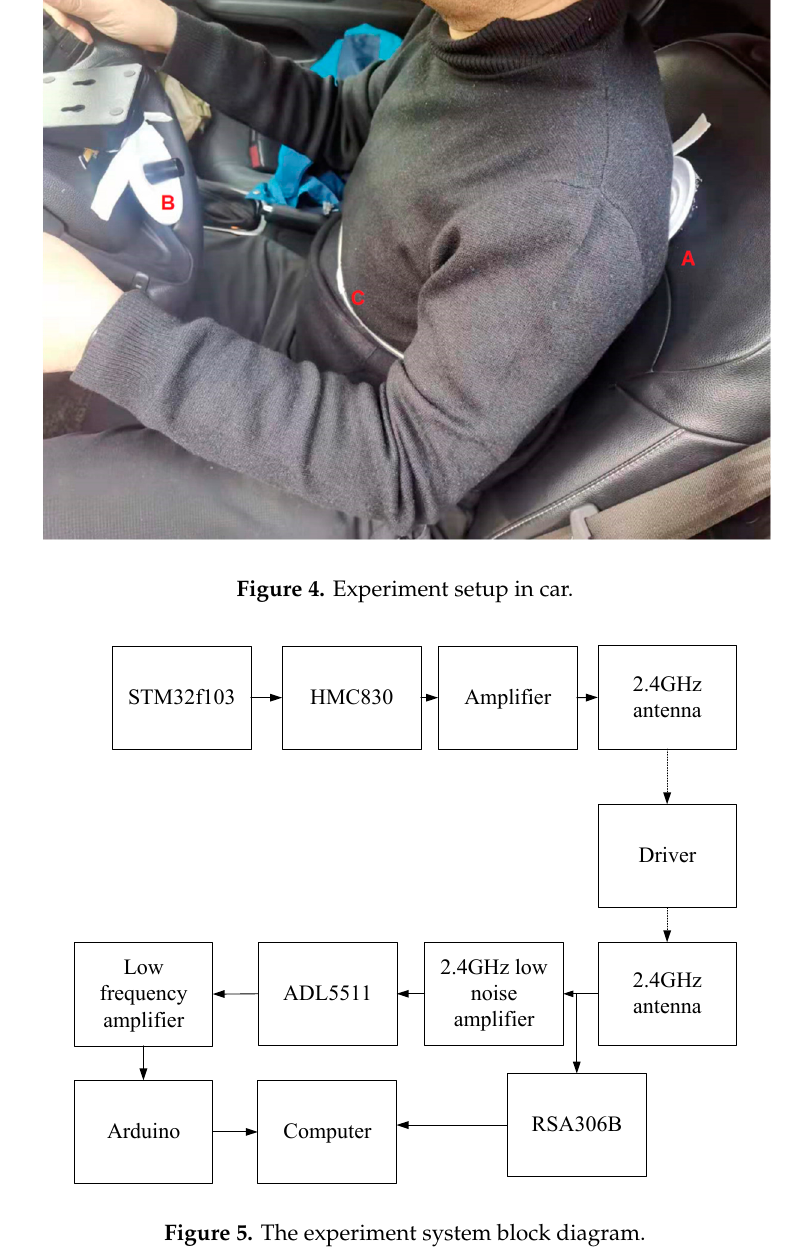
Figure 5. The experiment system block diagram.